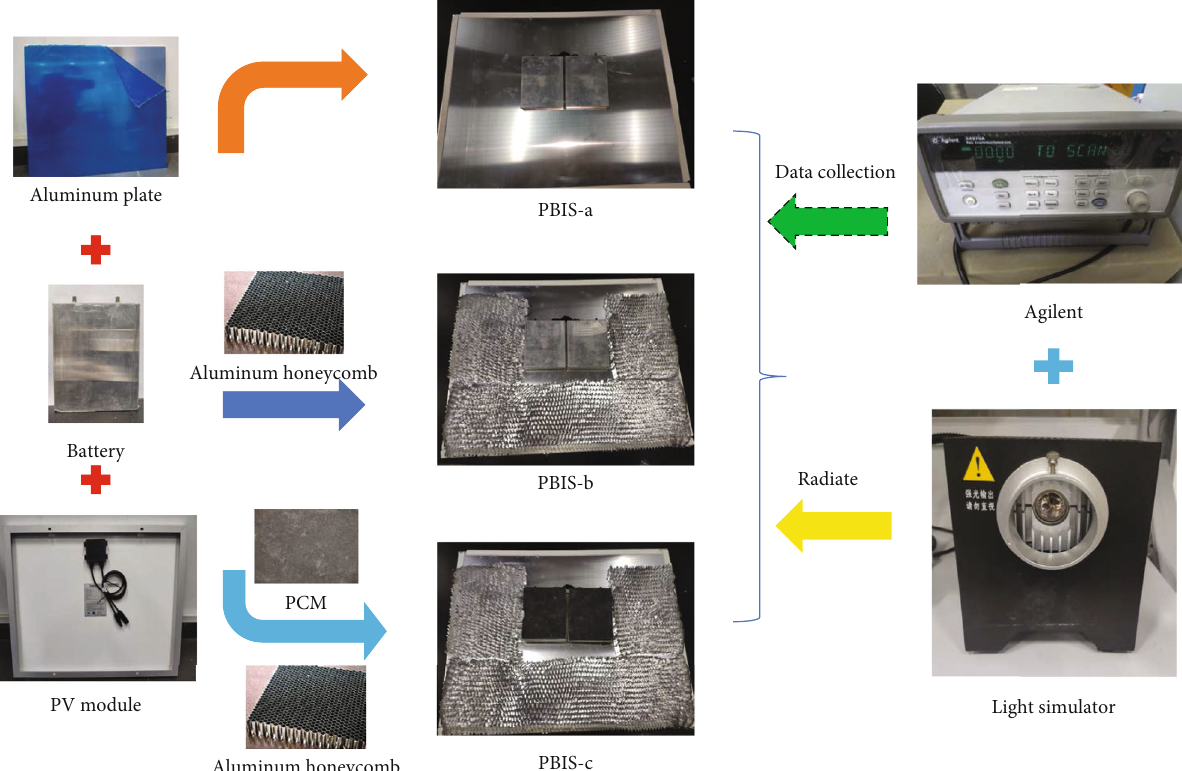
Figure 15: Model construction of PV – battery integrated